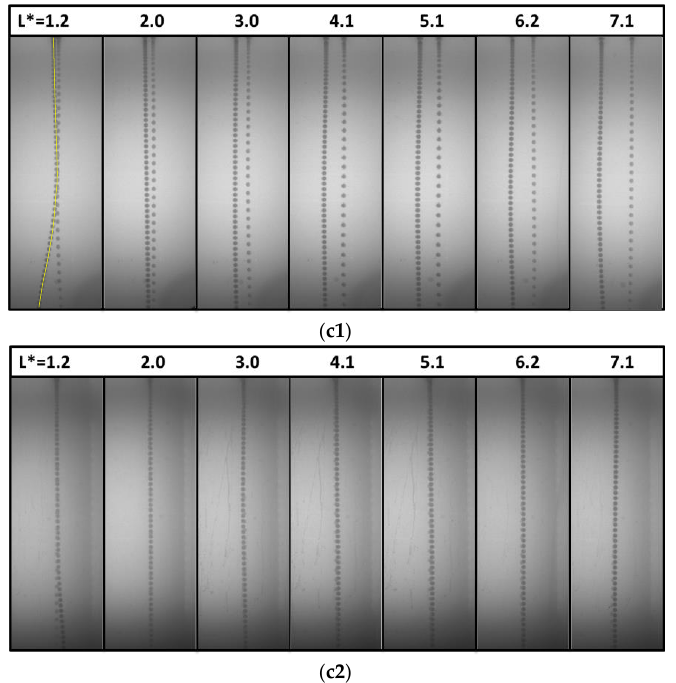
Figure 12. The settling process of two side-by-side particles at different initial separation distance under binocular vision; ( a1 ) x - z plane, Left particle: ZrO 2 , right particle: Stainless steel; ( a2 ) y - z plane, Particle: ZrO 2 , Stainless steel; ( b1 ) x - z plane; Left particle: Si 3 N 4 ; right particle: ZrO 2 ; ( b2 ) y - z plane, Particle: Si 3 N 4 , ZrO 2 ; ( c1 ) x - z plane; Left particle: Si 3 N 4 ; right particle: Stainless steel; ( c2 ) y - z plane, Particle: Si 3 N 4 , Stainless steel.